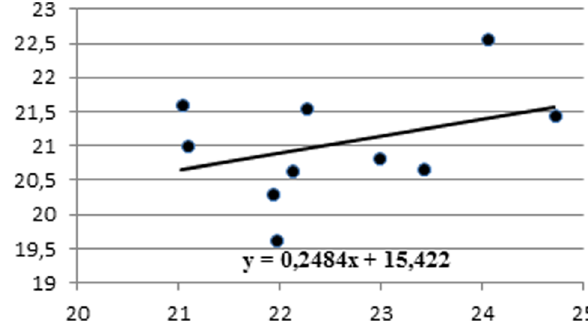
Figure 9: Linear approximation of the dependence of meat content on pre - slaughter weight in the dorsal - lumbar third of the